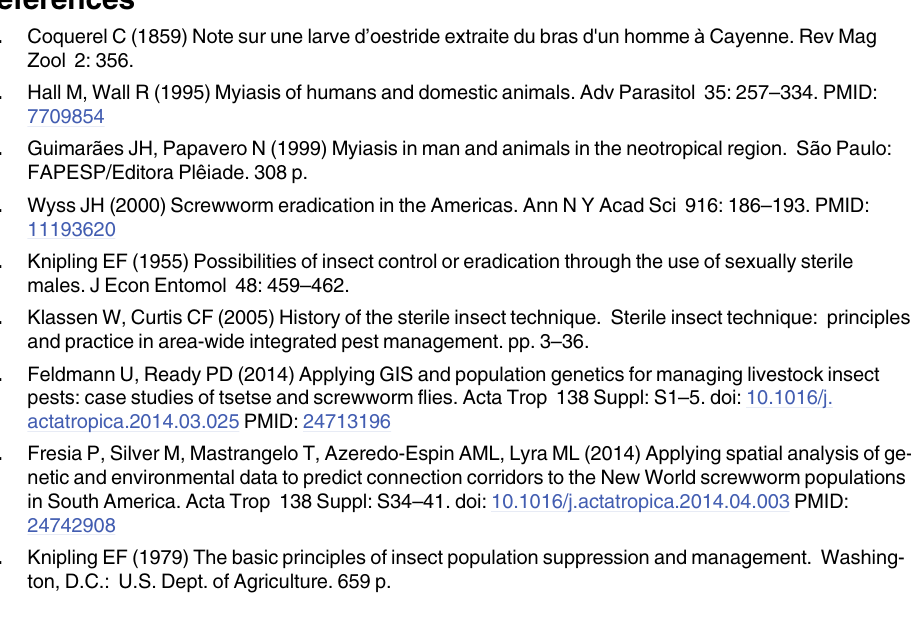
estimates from carboxylesterase E3 ( Ch α E7 ) data. Statistically signifi- S1 Table. Pairwise F ST cant values are in bold. estimates from mitochondrial data. Statistically significant values are S2 Table. Pairwise F ST in bold. S3 Table. Amino acids residues observed in positions 137 and 251 for 49 haplotypes of car- boxylesterase E3 ( Ch α E7 ) obtained from field samples. Additionally, mitochondrial haplo- types related to each carboxylesterase E3 ( Ch α E7 ) haplotype are shown. E3